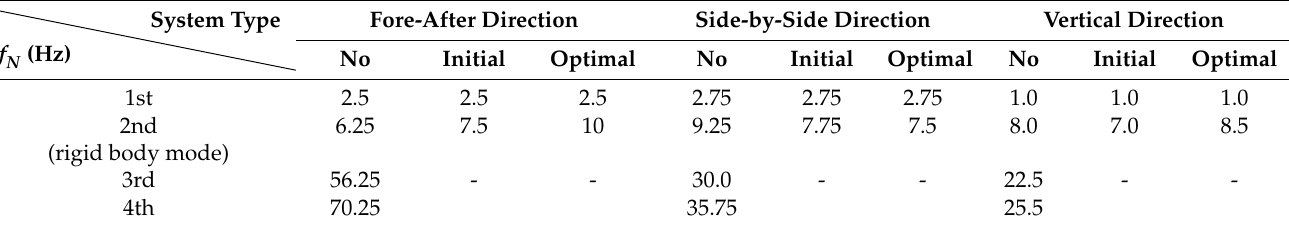
Figure 9. Comparison of transmissibility before and after the mount design modification in ( a ) fore-after, ( b ) side-by-side, and ( c ) vertical directions. Table 3. Comparison of natural frequencies of the initial and optimal